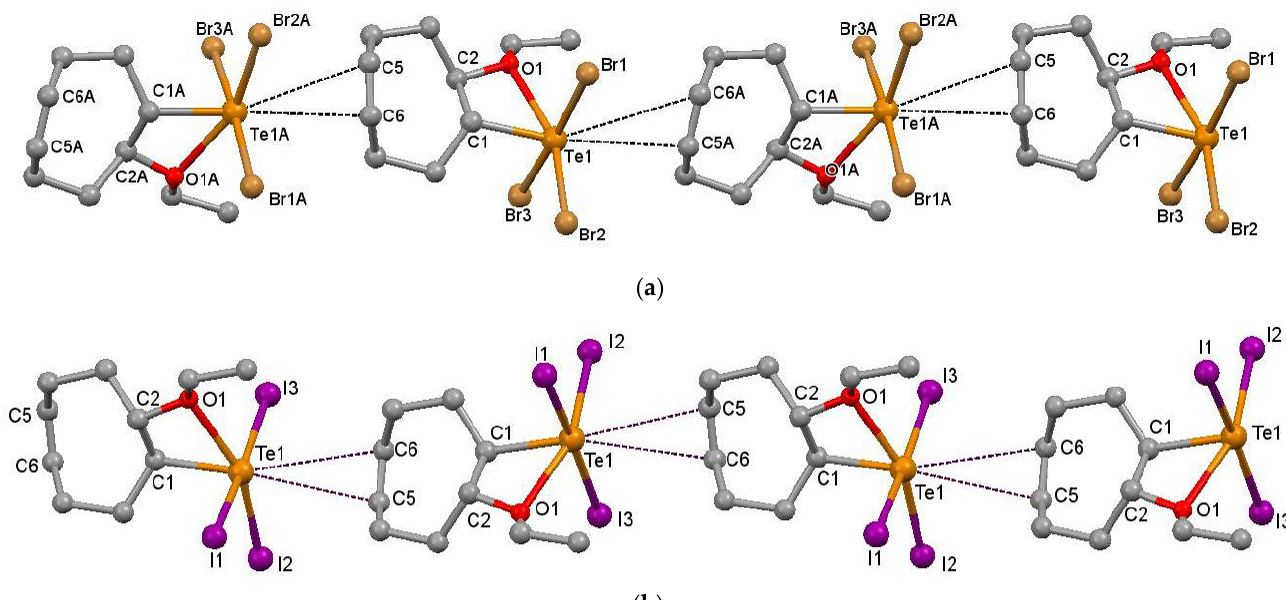
Figure 1. Fragments of the packing pattern of 1 (P21/c, Z’ = 2, ( a )) and 2 (Pbca, Z’ = 1 ( b )). Notice the ( a ) 1D chain of altering R,R and S,S molecules in 1 and the ( b ) 1D chain of S,S chain of 2 . Hydrogen atoms are omitted for clarity. Selected distances in 1 ( Ǻ ): (intramolecular) Br(2)-Te(1) 2.5224(5), Br(3)-Te(1) 2.6632(6), Br(1)-Te(1) 2.6826(5), O(1)-Te(1) 2.389(3); distances in 1 (intermolecular): Te(1A)-C(6) 3.430(3), Te(1A)-C(5) 3.648(4), Te(1)-C(6A) 3.830(4), Te(1)-C(5A) 3.435(3). Selected distances in 2 ( b ) ( Ǻ ): (intermolecular) Te1---C5 3.548(5), Te1---C6 3.592(5).